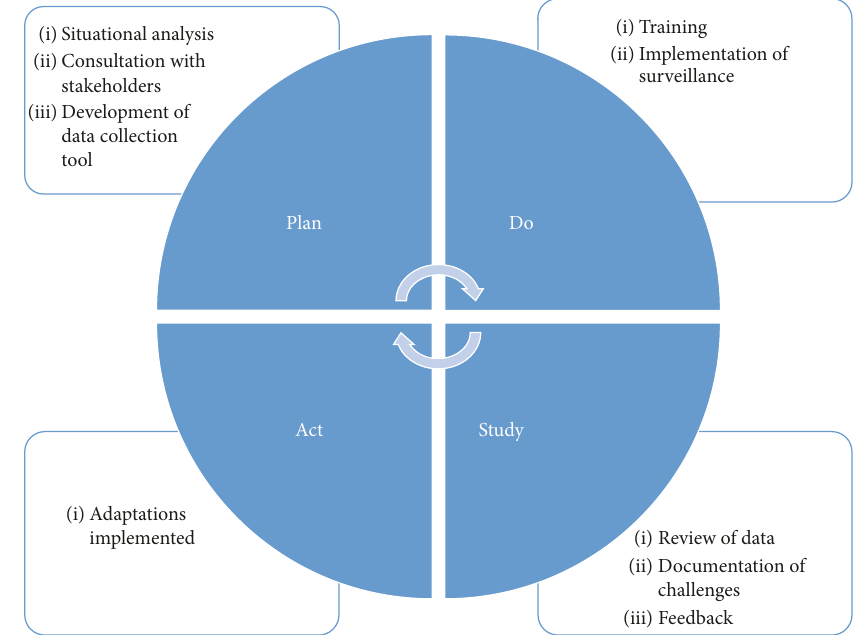
Figure 1: Adapted Plan-Do-Study-Act cycle approach used to implement an HAI surveillance system in